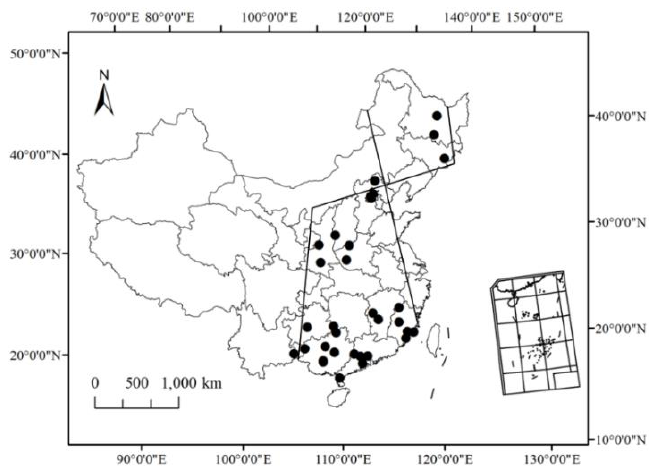
Figure 1. Locations of research plots in this synthesis in eastern China (black dots). The region between the two lines represents the area of the North – South Transect of Eastern China (NSTEC).